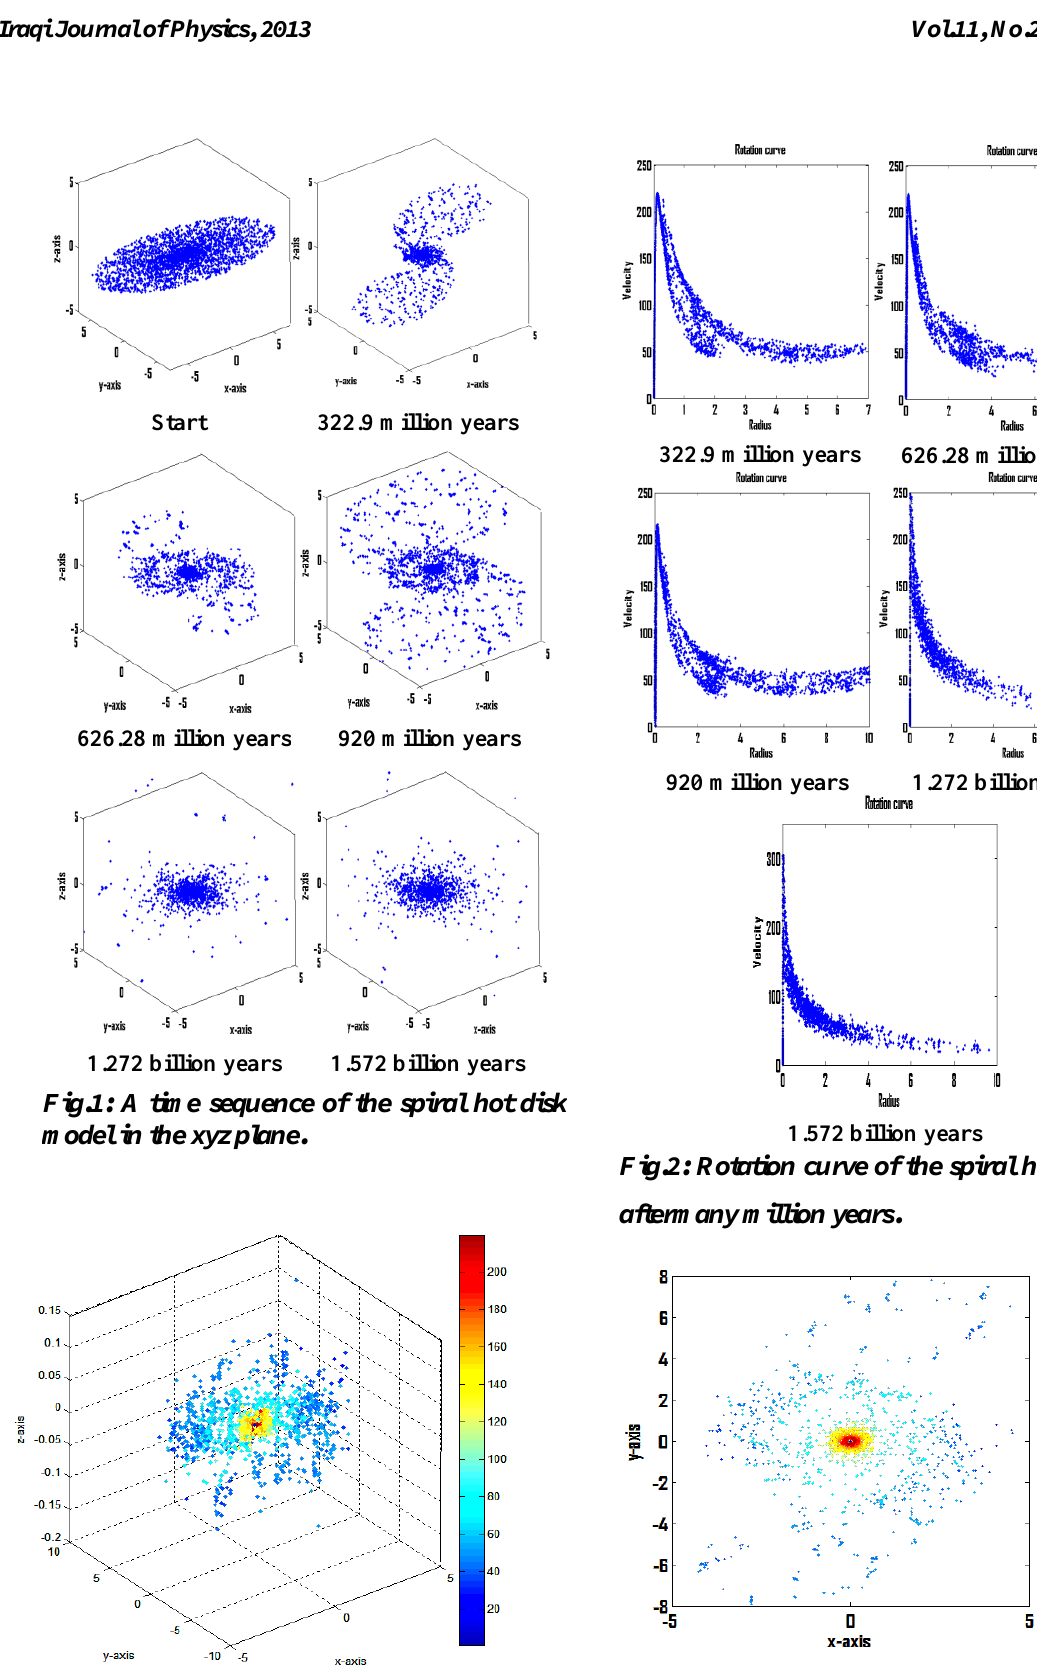
Fig.3: Velocity distributions in xyz plane of the spiral hot disk model after 626.28 million years.